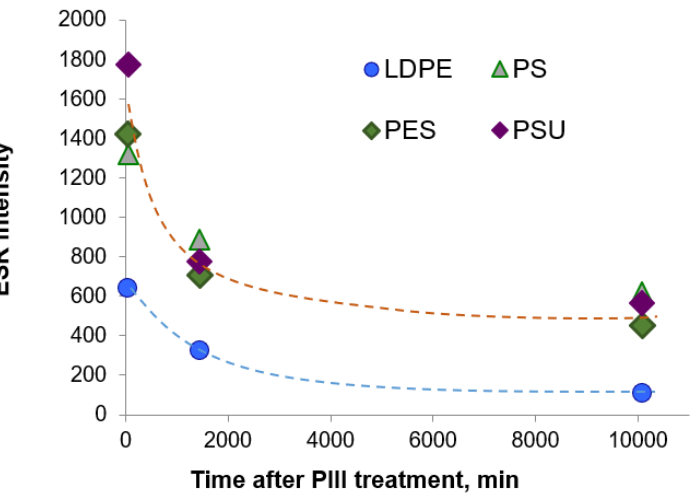
Figure 6. Radical decay on PIII-treated polymers during storage at ambient conditions for the first 7 days after the treatment. 7 days after the